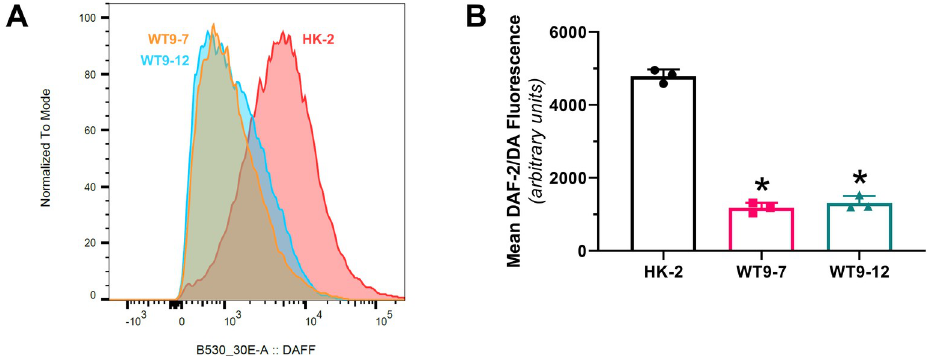
Fig 2. Fluorescence-activated cell sorting (FACS) analysis for diaminofluorescein-2/diacetate (DAF-2/DA) in unstimulated human ADPKD (WT 9–7 and WT 9–12) and normal kidney (HK-2) cells. (A)